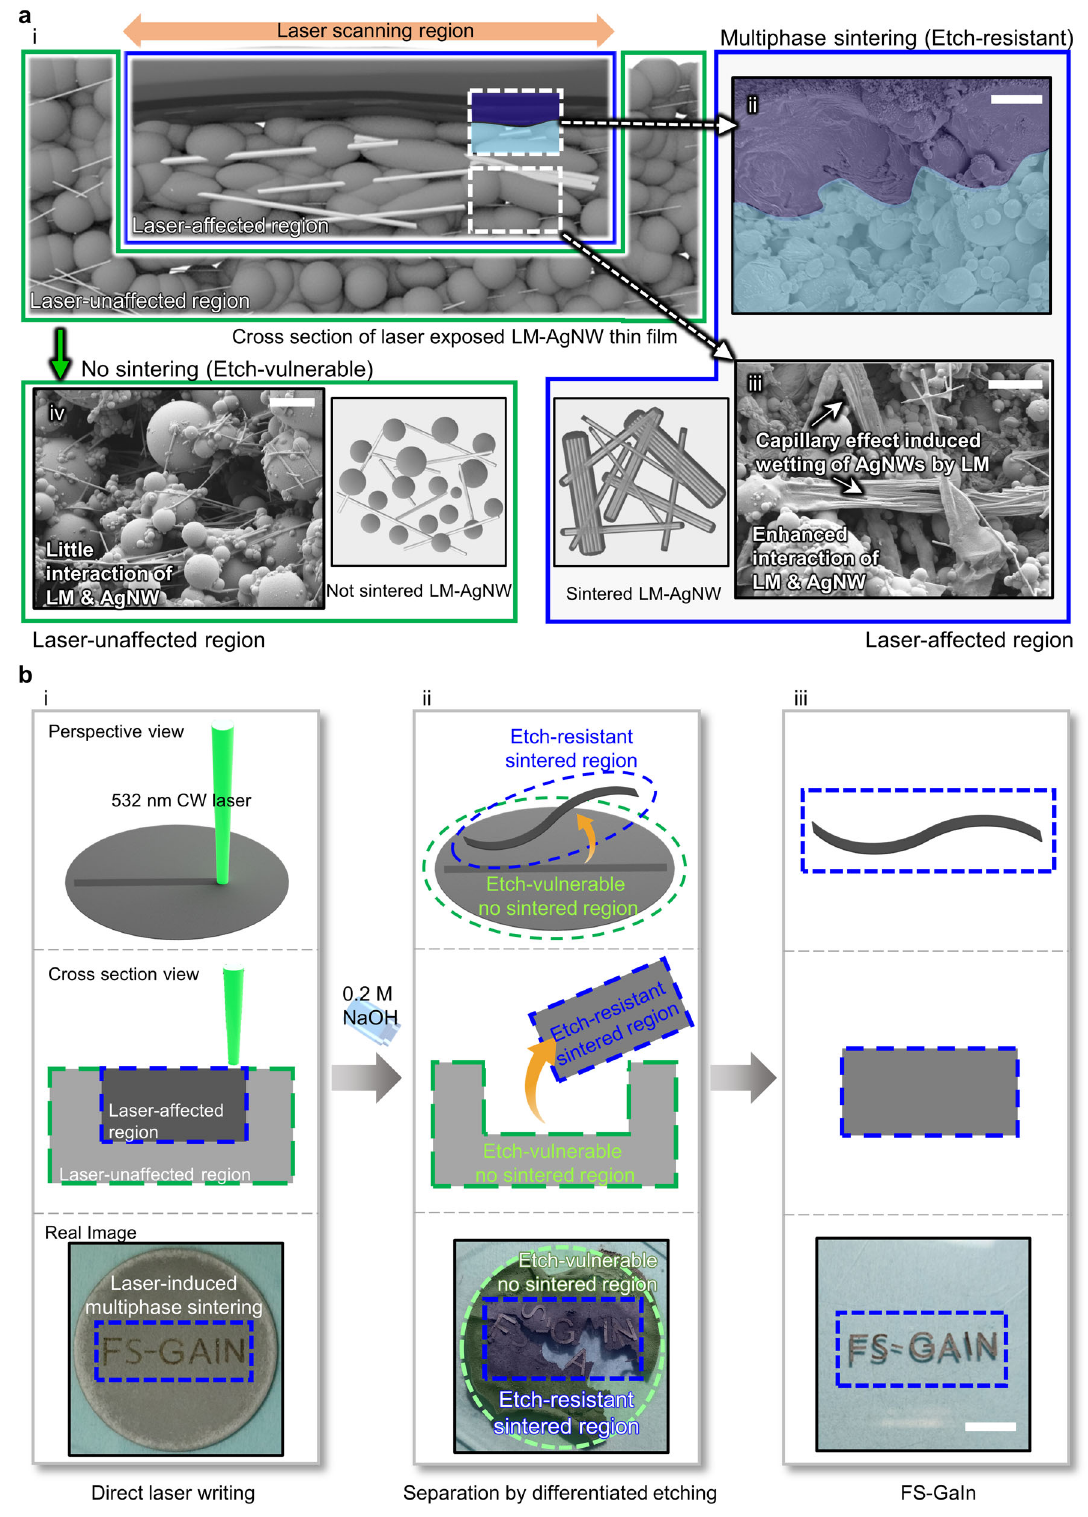
Fig. 2 FS-GaIn fabrication principle and process. a (i) Schematic illustration of the laser-scanned LM-AgNW thin- fi lm in cross-section view. The blue and green box represents laser scanned and non-scanned region, respectively. (ii) SEM image of the laser-scanned near-the-surface region as a cross-section view with pseudo-colors. (iii) SEM image of the laser-scanned deeper region and schematic illustration of multiphase sintered LM-AgNW. (iv) SEM image of the non-laser-scanned region and schematic illustration of not sintered LM-AgNW. b The fabrication process of FS-GaIn in perspective view, cross-section view, and real image. (i) Direct laser writing on the LM-AgNW thin- fi lm. (ii) FS-GaIn separation by differentiated etching. (iii) The fabricated FS-GaIn. Scale bars: 3 μ m ( a ), 9 mm ( b